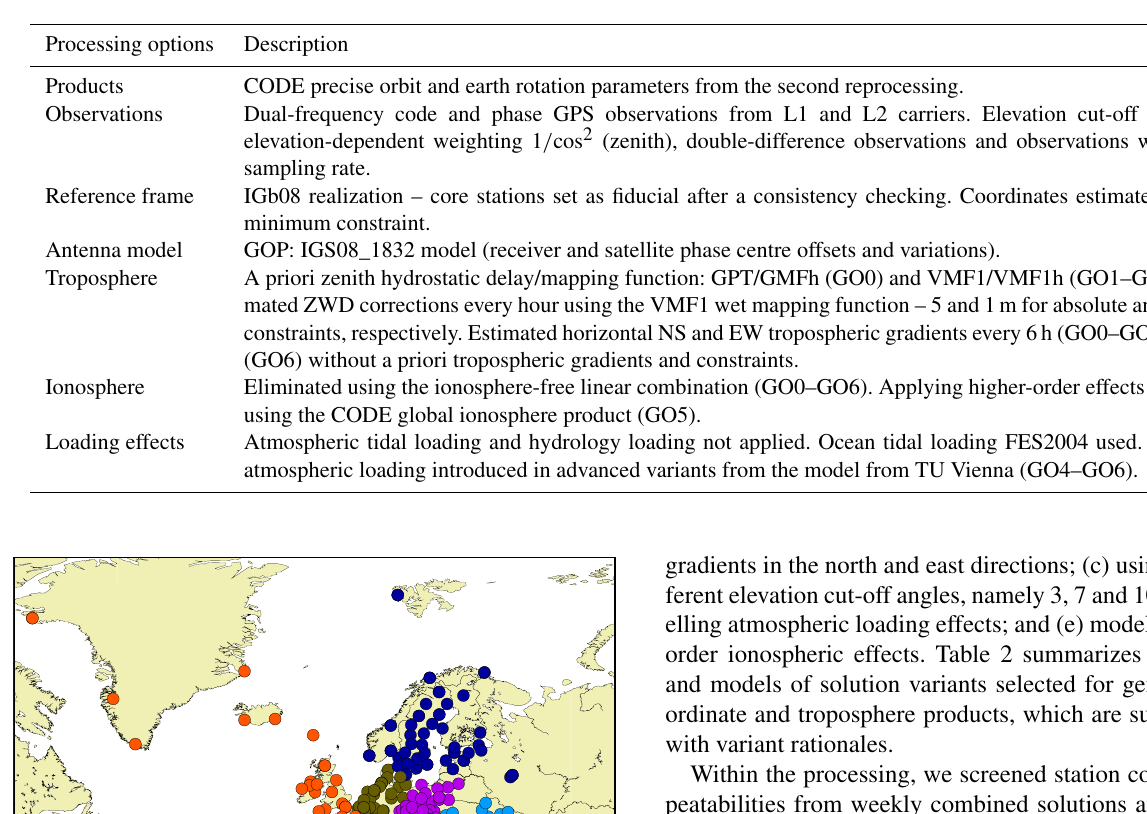
Table 1. Characteristics of GOP reprocessing models.